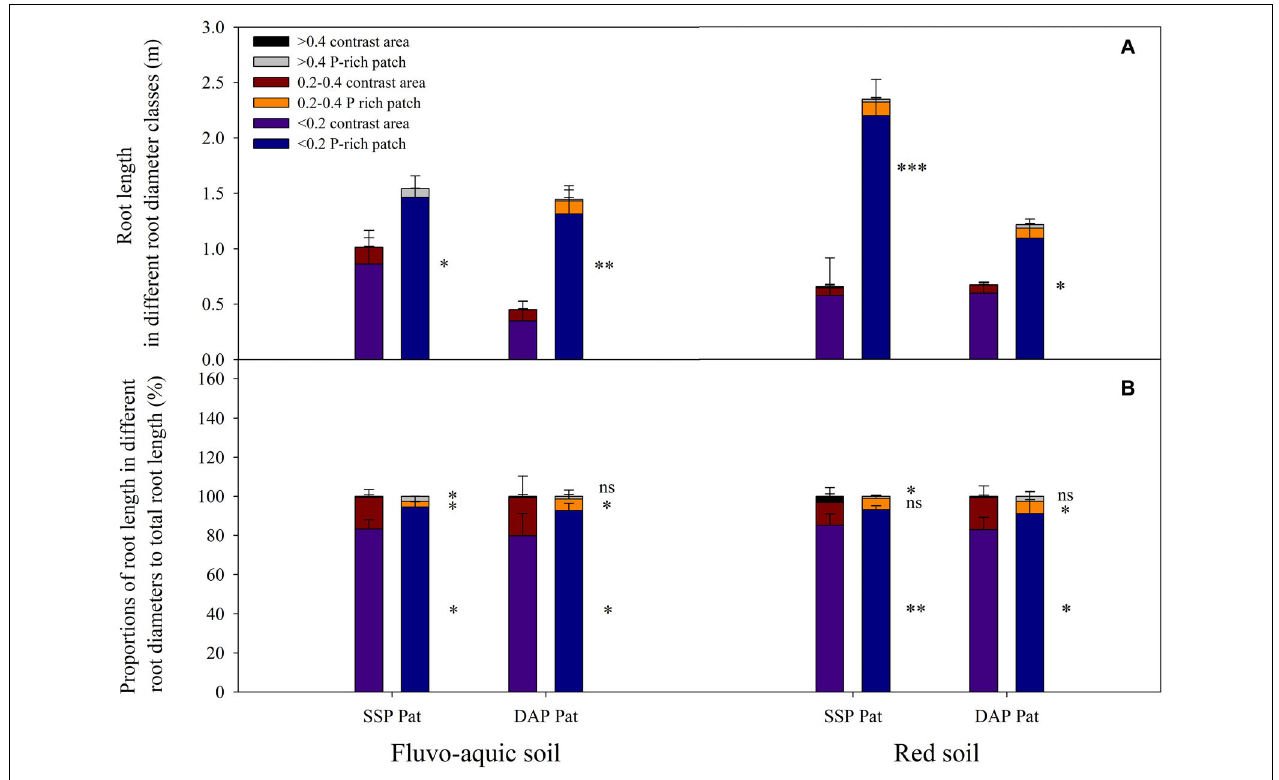
FIGURE 3 | Root length in different root diameter classes (A) and proportions of root length in different root diameters to total root length (B) in fluvo-aquic soil and red soil with localized P supply. Asterisks indicate significant differences between P-rich patches and contrast areas in the same rhizobox (significance level: